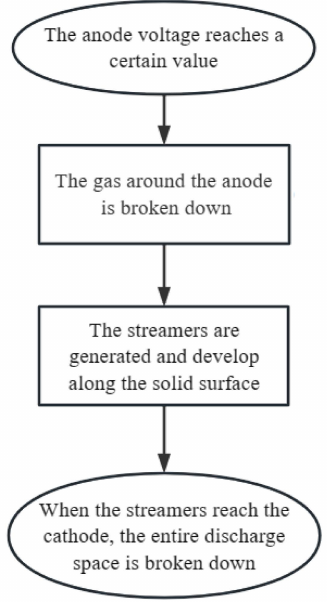
Figure 2. Flow chart of the surface